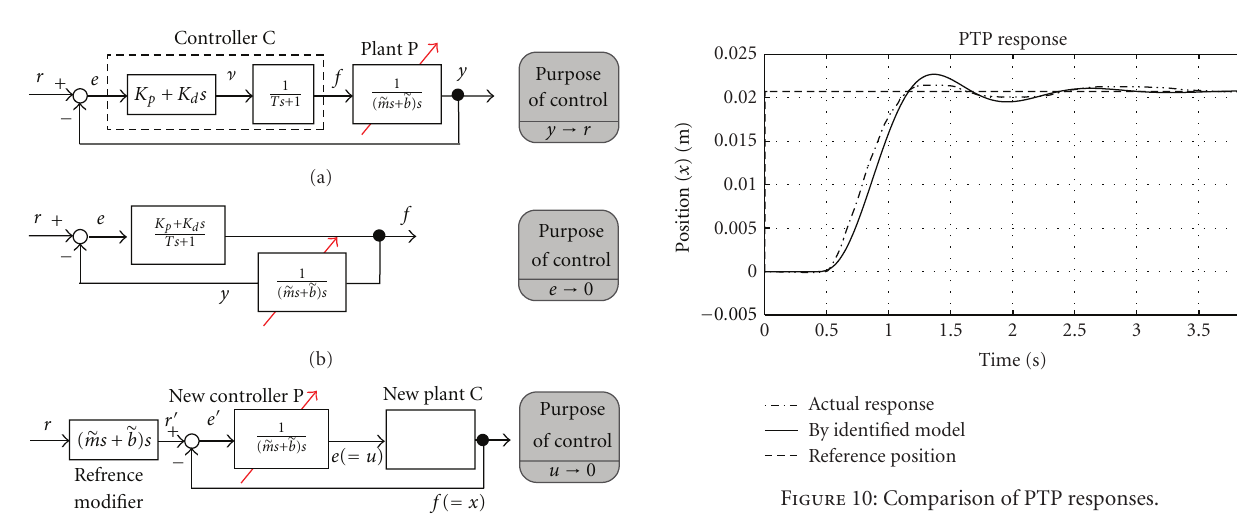
Figure 8: A human control model and its identification.